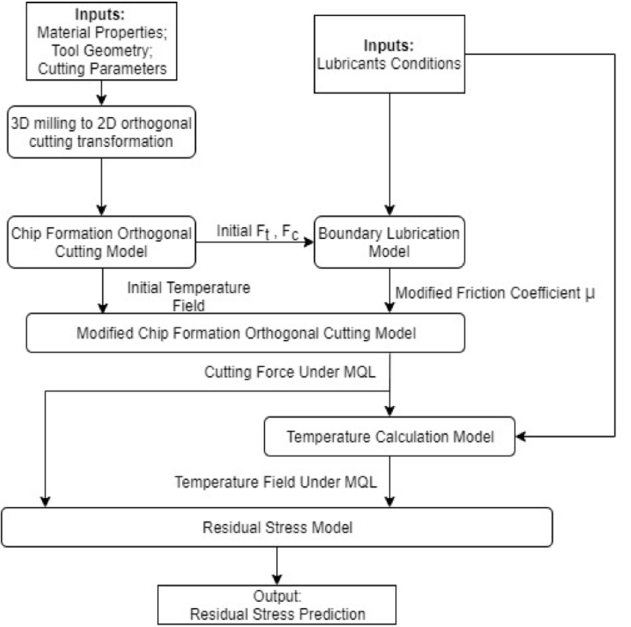
Fig. 1. Flow chart of the residual stress calculation.